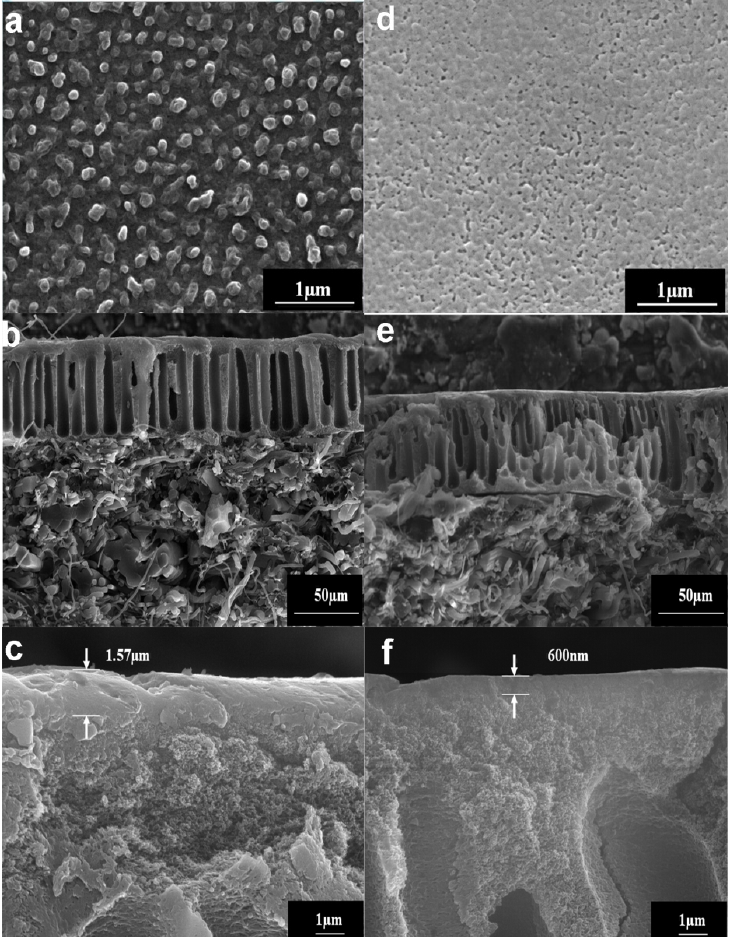
Separations 2022 , 9 , x FOR PEER REVIEW Figure 1. SEM images of NF-C ( a-c ) and NF-0.75PNP ( d-f ). Figure 1. SEM images of NF-C ( a – c ) and NF-0.75PNP ( d – f ).